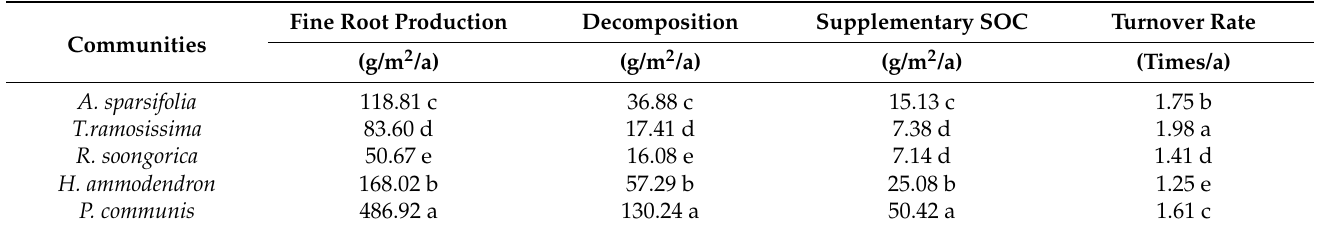
Table 3. Fine root productivity, decomposition, decomposition of supplementary soil organic carbon (SOC), and turnover rate of the five plant